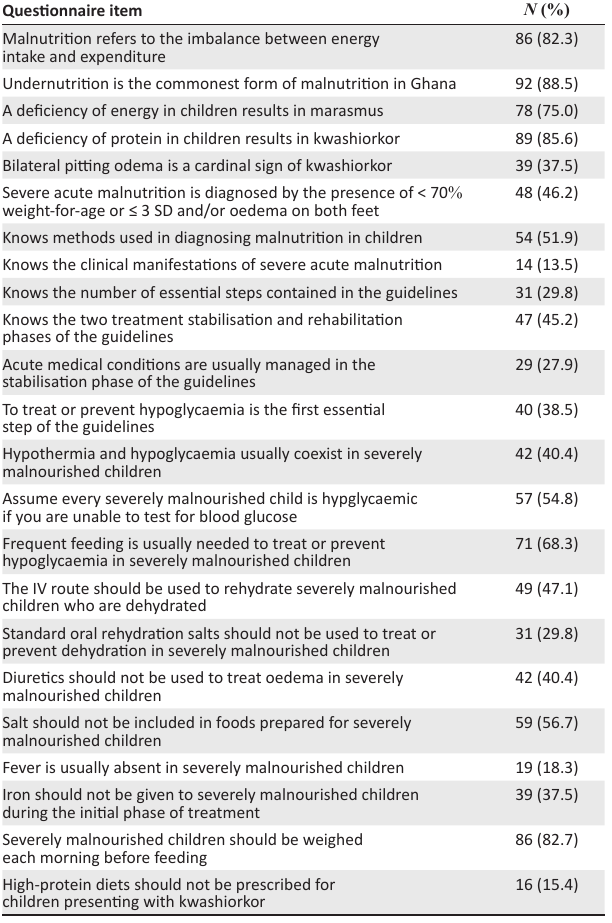
TABLE 3: Percentage of correct answers to the individual knowledge items. Questionnaire item N